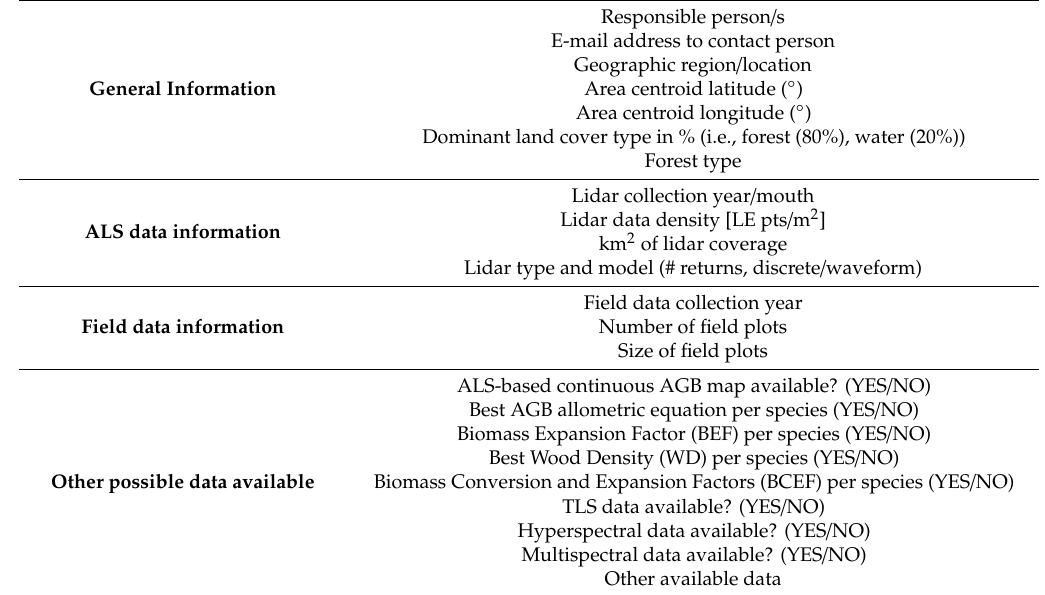
Table 1. Groups of metadata collected in the GlobALS